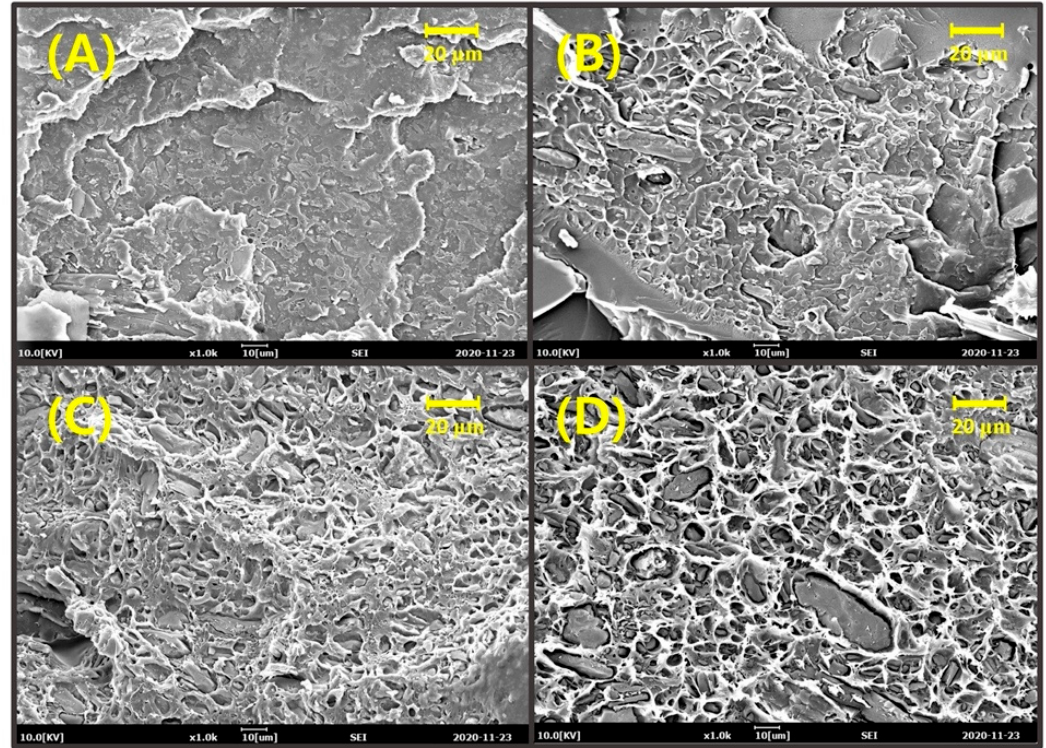
Figure 2. SEM micrographs of cryogenically fractured surfaces: poly(lactic acid) (PLA)-based biocomposites with pristine lignin ( A ) 5 wt.%, ( B ) 10 wt.%, ( C ) 15 wt.%, and ( D ) 20 wt.%, respectively.